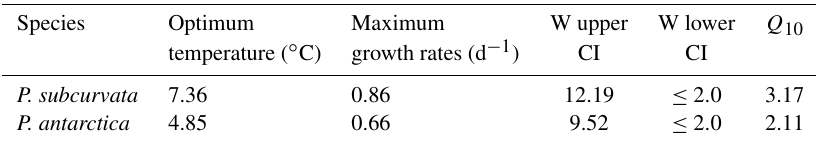
Table 2. Statistical comparison of the results for each of the three thermal traits: optimum temperature ( ◦ C), maximum growth rate (d − 1 ) , and temperature niche width (W) ∗ of P. subcurvata and P.